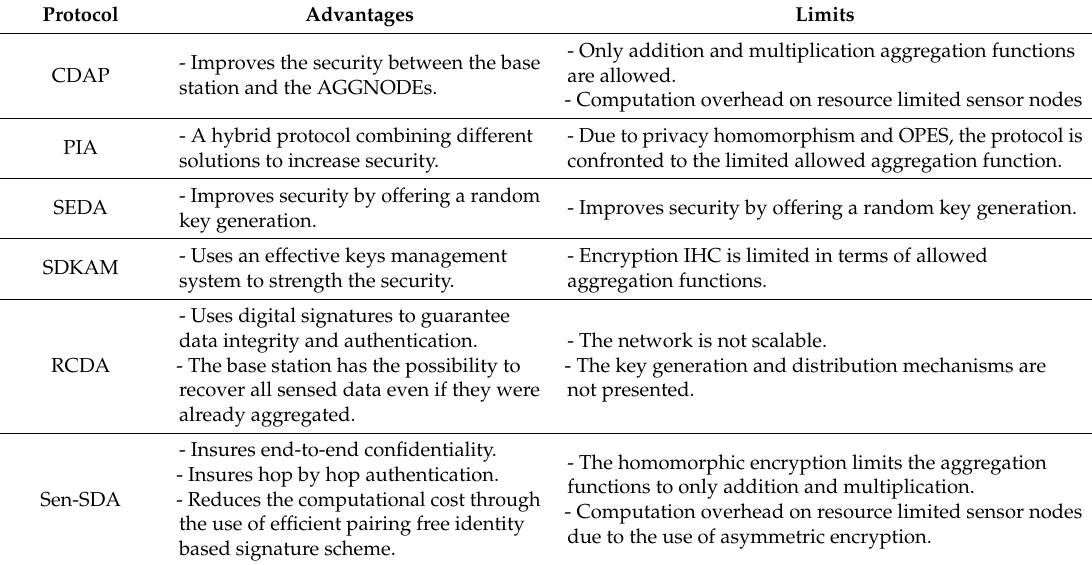
Table 1. The end to end heterogeneous data aggregation security protocols.